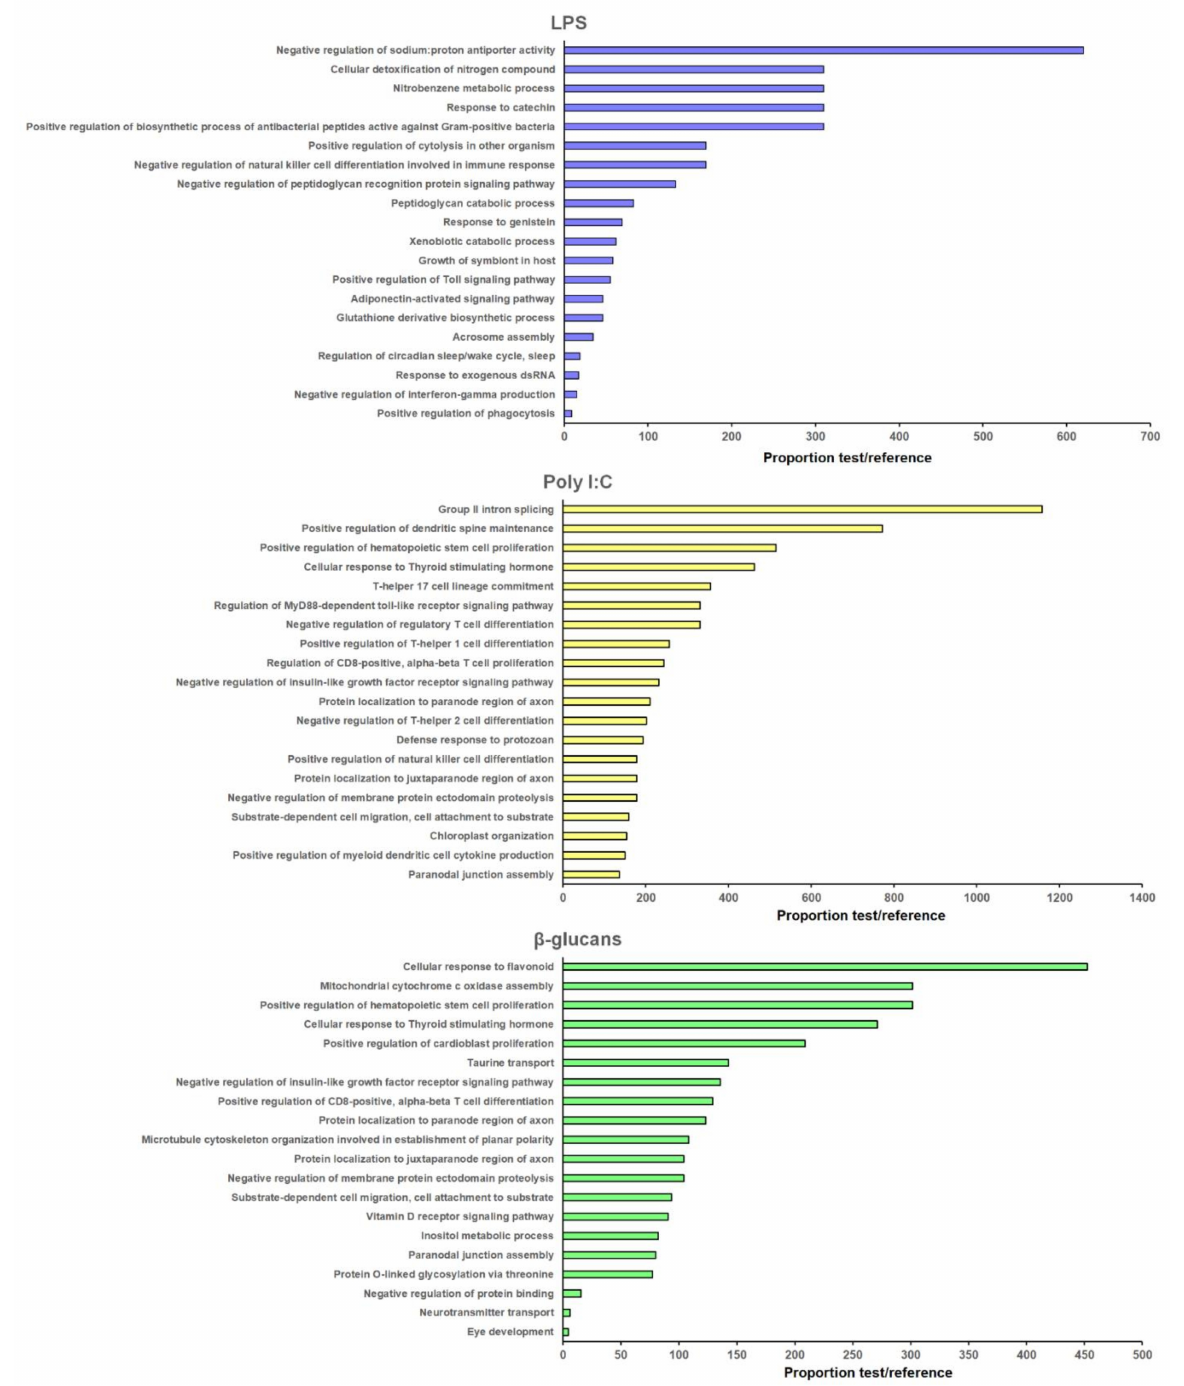
Figure 4. GO enrichment analyses of the neighboring coding genes of those lncRNAs differentially expressed in stimulated hemocytes. The 20 most enriched biological processes among the protein-coding genes proximal to lncRNAs are